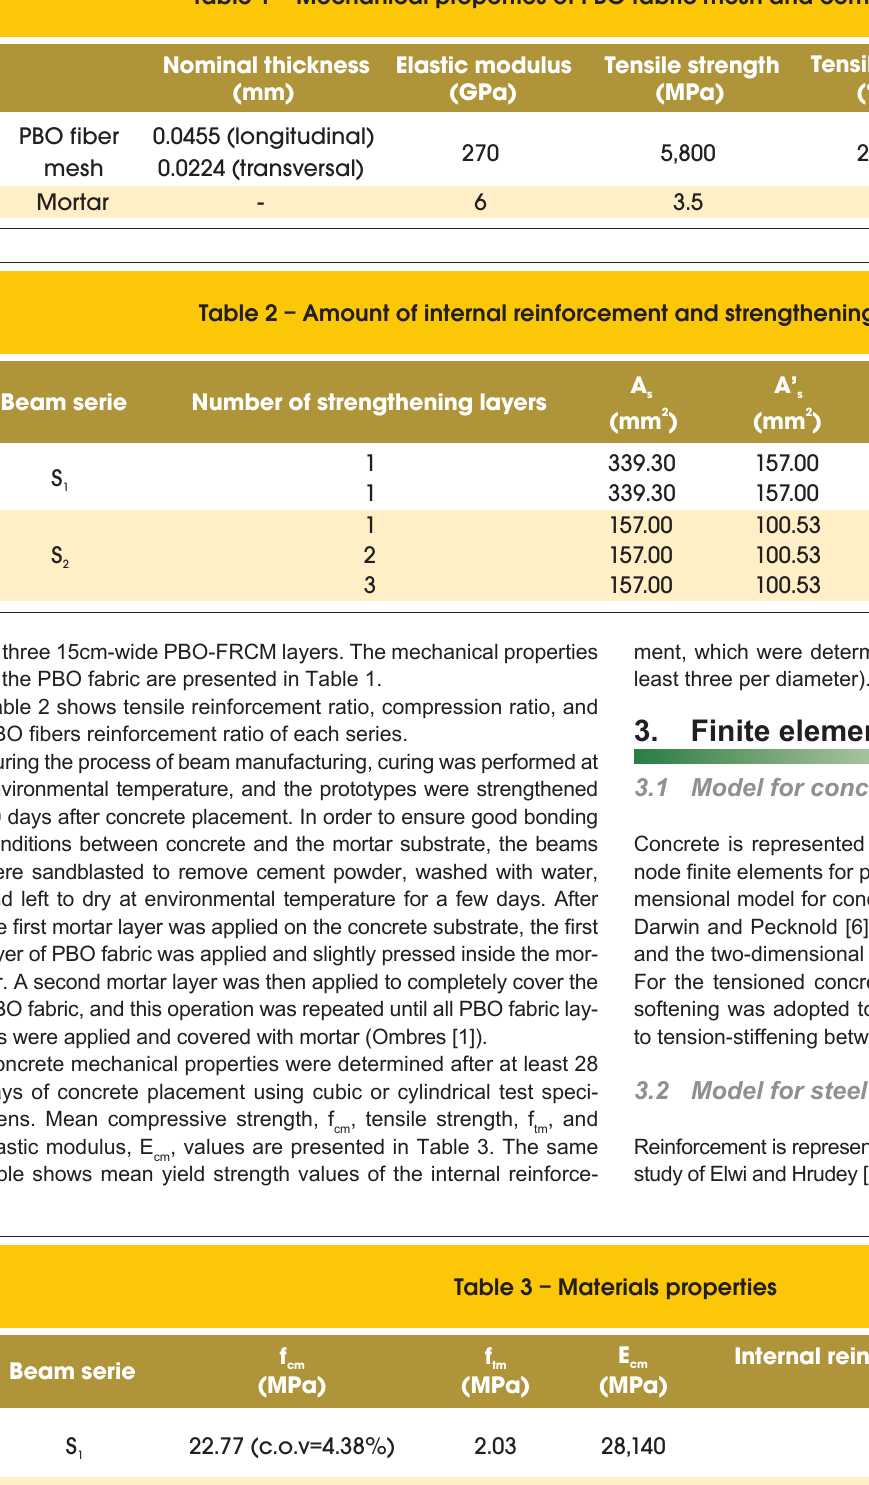
Table 1 – Mechanical properties of PBO fabric mesh and cementitious mortar